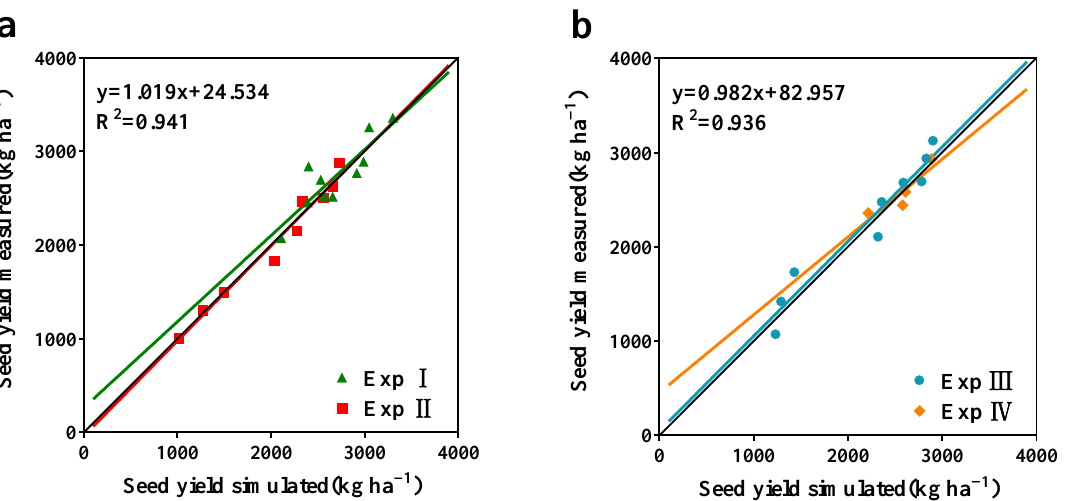
Figure 3. Relationship between simulated and measured yield for the calibration datasets I and II ( a ) and the evaluation datasets III and IV ( b